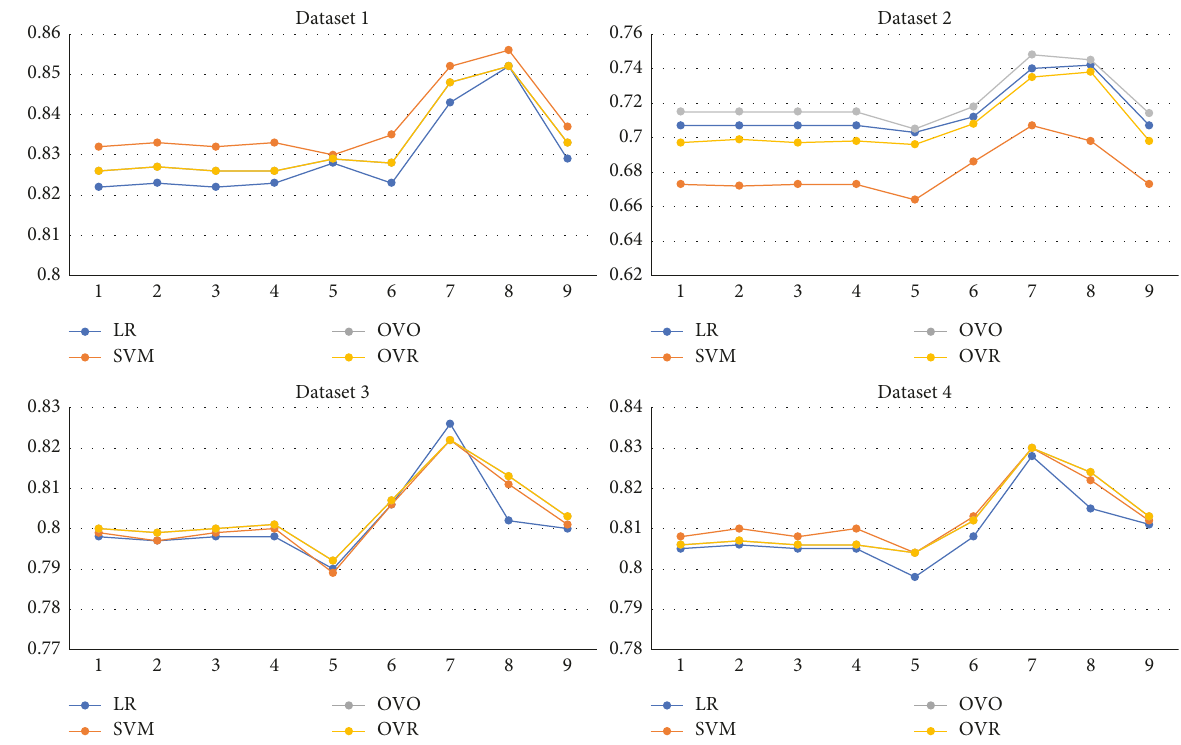
Figure 3: The accuracy results of various preprocessing techniques for Vietnamese sentiment analysis based on machine learning